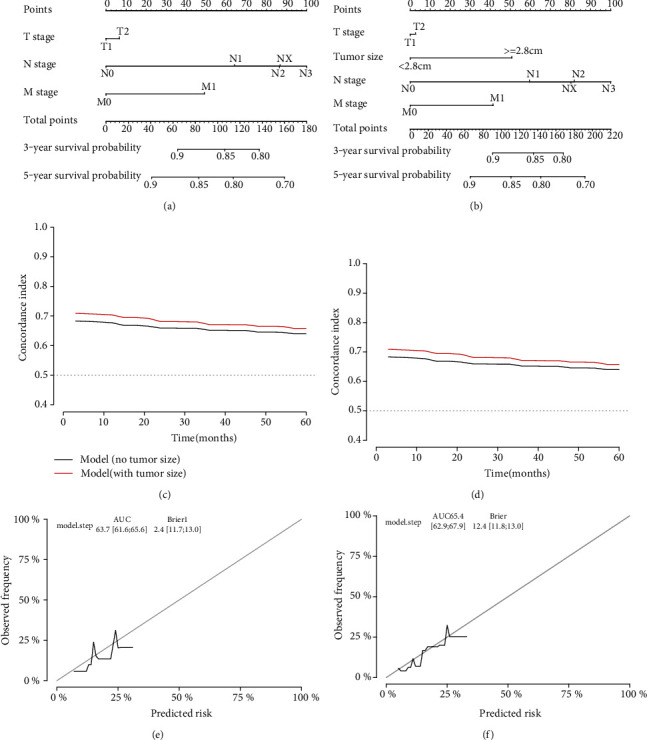
Construction of the nomogram in the T1-2 stage. (a) Nomogram incorporated tumor size and the TNM stage. (b) Nomogram incorporated with the TNM stage. (c) c-index of the nomogram by the times in the CSS set. (d) c-index of the nomogram by the times in the OS set. (e) The internal validation of the model with no tumor size. (f) The internal validation of the model with tumor size.